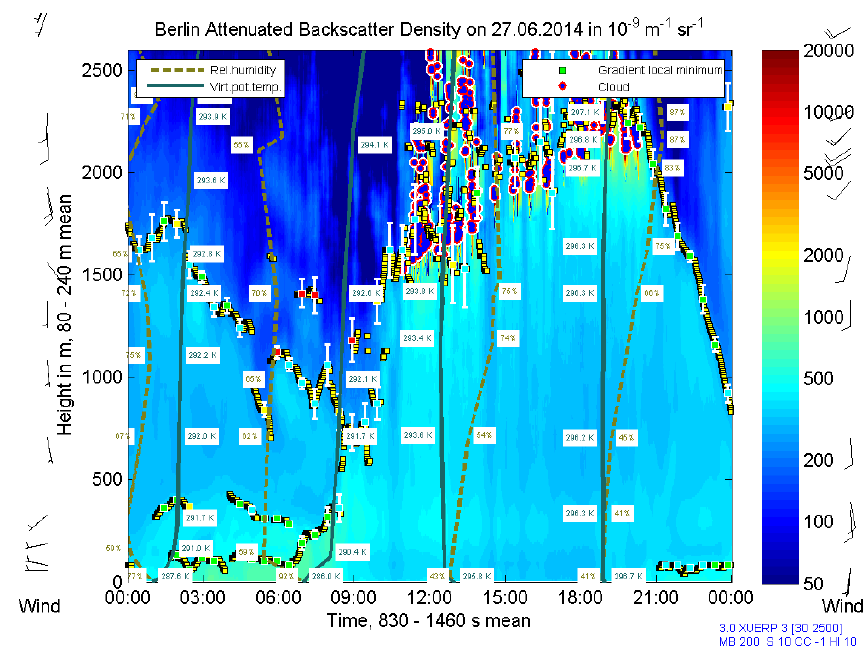
Figure 2. The development of the boundary layer thickness on 27 June according to ceilometer measurements performed by IMK-IFU in